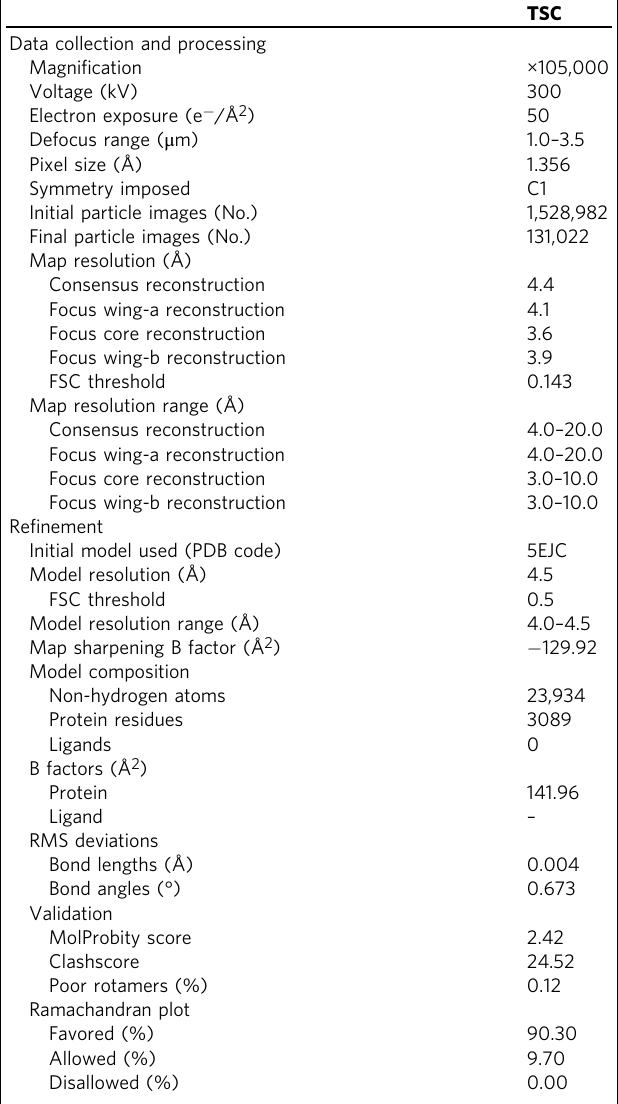
Table 1 Statistics of cryo-EM data collection, re fi nement, and validation